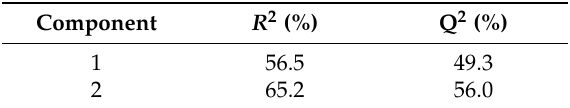
Table 1. Percent cumulative sum of squares explained ( R 2 ) and predicted (Q 2 ) by the principal component analysis (PCA) model built on attenuation features collected from anode slices.